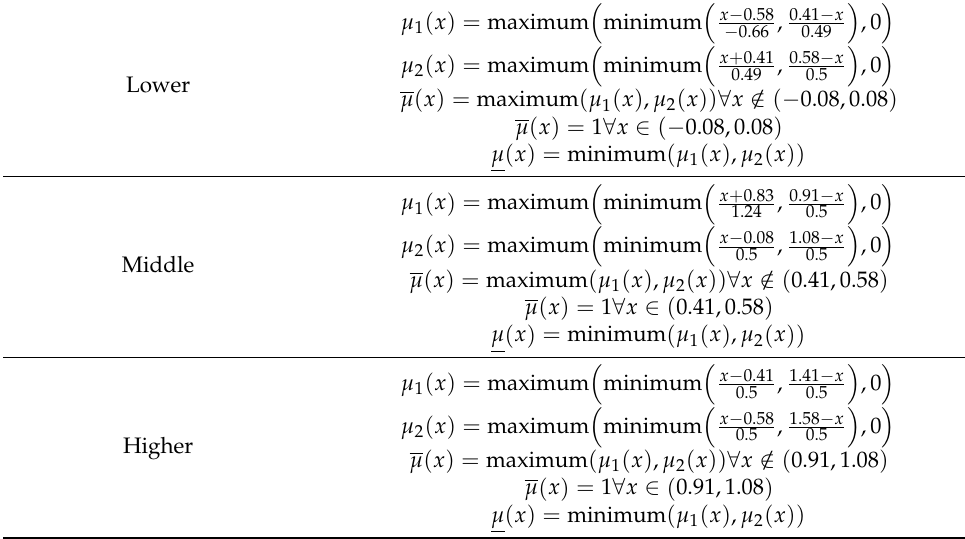
Table 1. Partial knowledge of the interval type-2 fuzzy system (IT2FHS) expressed in the membership functions.